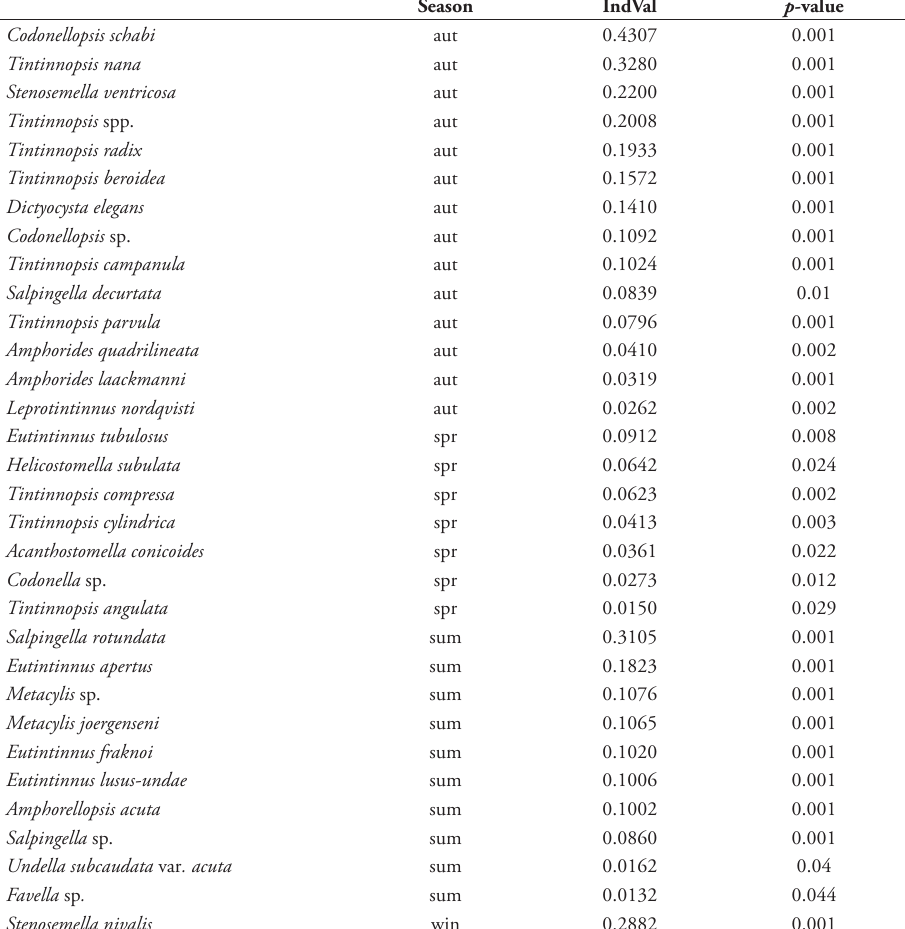
Table 4. List of tintinnid taxa and significant IndVal for each season; taxa are ordered by season and decreasing IndVal values. aut=autumn; spr=spring; sum=summer;